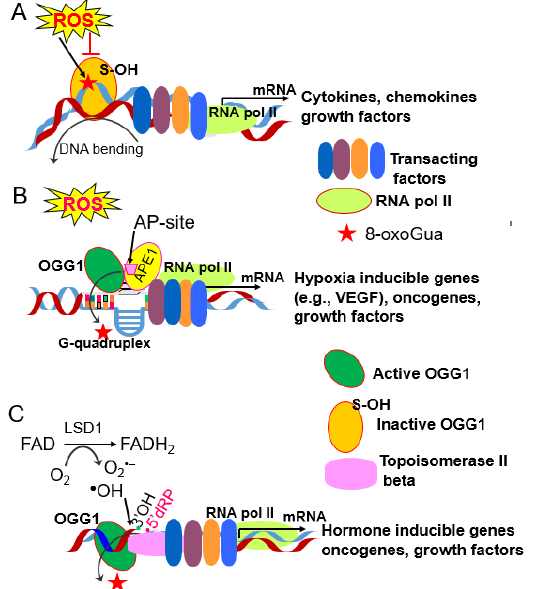
Figure 2. Models for OGG1-8-oxoGua-dependent gene expression. ( A ) Viral infection-induced ROS or those generated by cytokine exposure oxidatively modify guanine to 8-oxoGua and inactivate OGG1 ′ glycosylase activity by reversible oxidation at cysteine residues (cysteine-sulfenic acid). Oxidatively disabled OGG1 flips 8-oxoGua into its active-site pocket, interacts with the opposing cytosine and results in the conformational change of the DNA helix, which favors TFs DNA occupancy. ( B ) OGG1-8-oxoGua driven gene expression under hypoxic conditions. Guanines in gene promoters with G-quadruplexes are highly sensitive to ROS and are oxidized to 8-oxoGua under tissue hypoxia, caused by SARS-CoV-2, RSV, or H1N1 infections during pneumonia. OGG1 excises 8-oxoGua and generates an AP-site a substrate for APE1. APE1 binding leads to melting of the guanine duplex and stalls because of the non-canonical structure. Stalled APE1 increases transcription factor loading on the DNA via transient cooperative binding via conformational change of the helix. APE1, via its interacting domain, interacts with TFs (e.g., HIF1- α , STAT3, and CBP/p300) to modulate their redox state and promote both their binding to cis elements and gene expression. ( C ) OGG1-dependent transcription initiated by estrogens and its nuclear receptor. Estrogen (17 β -estradiol; E2) binding to estrogen receptor alpha (ER α ) results in demethylation of histone H3 lysine 9 (H3K9me2) via lysine-specific histone demethylase (LSD1; a flavin-dependent amine oxidase). Histone demethylation leads to a focal superoxide anion, hydroxyl radical generation and induces site-specific oxidation of guanine to 8-oxoGua. The latter is recognized and excised by OGG1 and via its AP-lyase activity cleave into the DNA strand generating the AP-site. The strand gap is recognized by topoisomerase II beta (topo IIb), which results in DNA structural changes in the chromatin allowing efficient assembly of transcriptional machinery and gene expression. Such scenarios are relevant to acute lung injury and SARS-CoV-2 infection capacity [138,139]. Similarly, LSD1-dependent DNA oxidation and OGG1 recruitment was needed for gene expression driven by TNF α , retinoic acid, and androgen exposure of cells [140–142]. Abbreviations: AP-site, apurinic/apyrimidinic site; APE-1, apurinic/apyrimidinic endonuclease 1; FAD, flavin adenine dinucleotide; FADH2, reduced flavin adenine dinucleotide; LSD1, flavin-dependent amine oxidase 1, 3-OH, 3-terminal hydroxyl; 5 ′ -dRP, 5-terminal deoxyribose-phosphate.